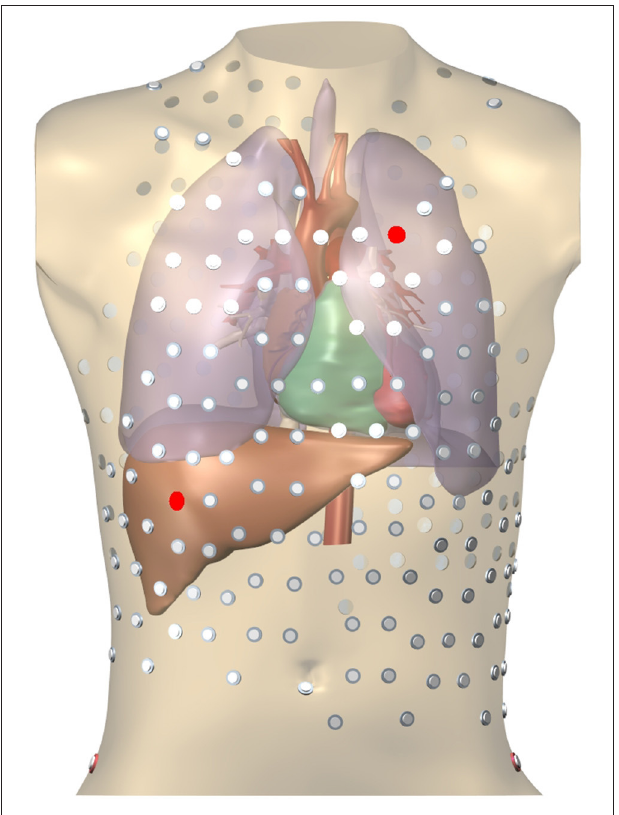
FIGURE 3 | Heart-torso mesh used for the computation of validation data. The 252-electrode body surface mapping set is shown. Red electrodes mark two locations used in Figure 8